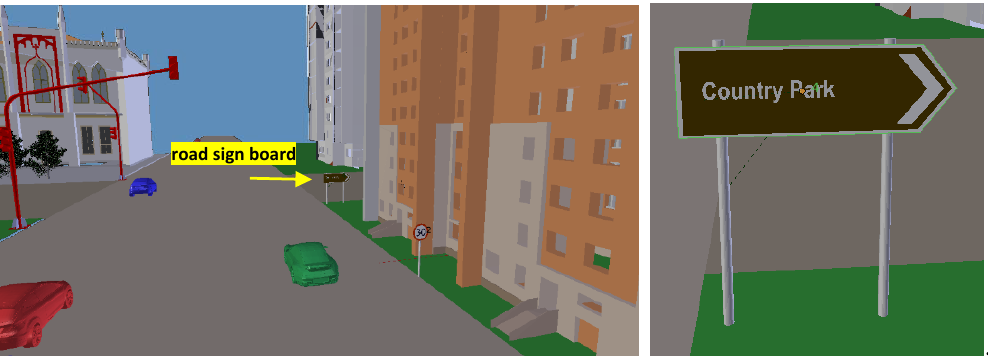
Figure 12. Traffic sign testing.